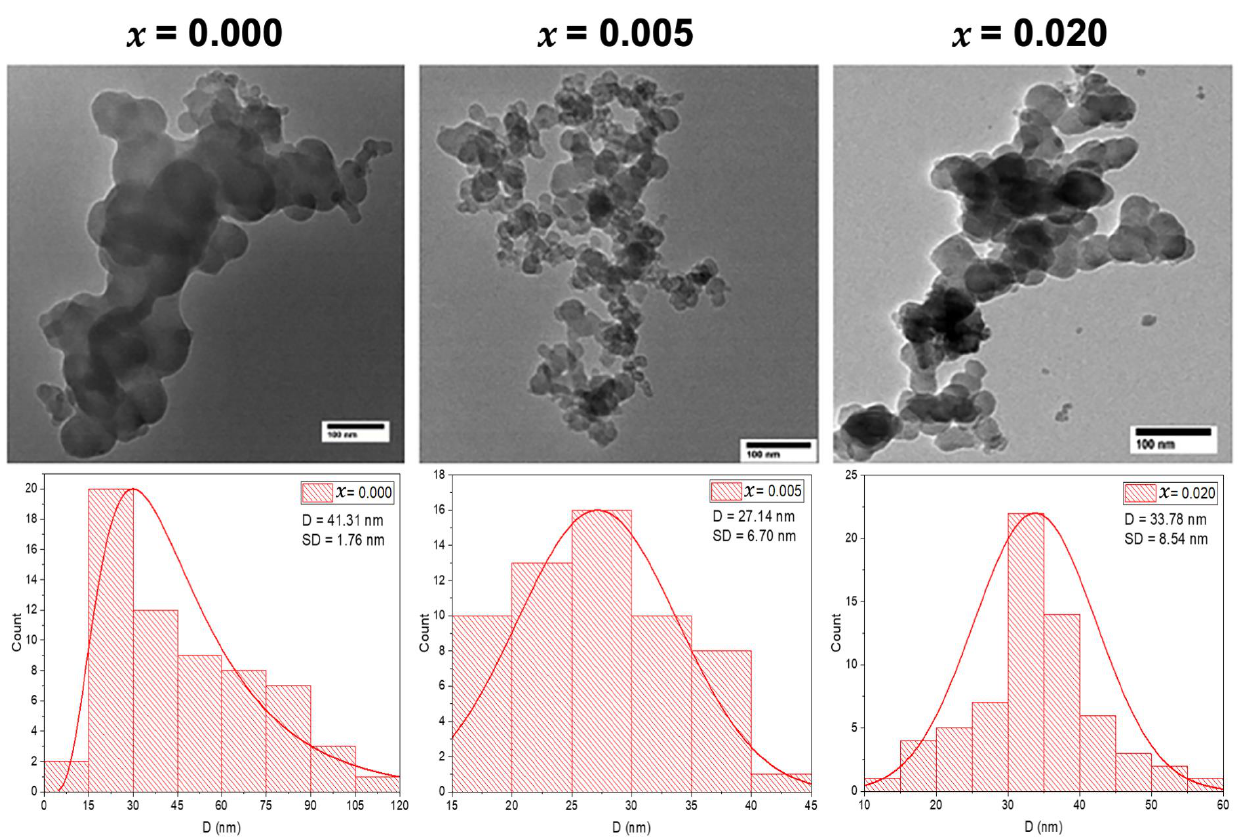
Figure 2. TEM images with the grain size distribution of the undoped and Mg-doped CuO NPs (Cu 1 −x Mg x O